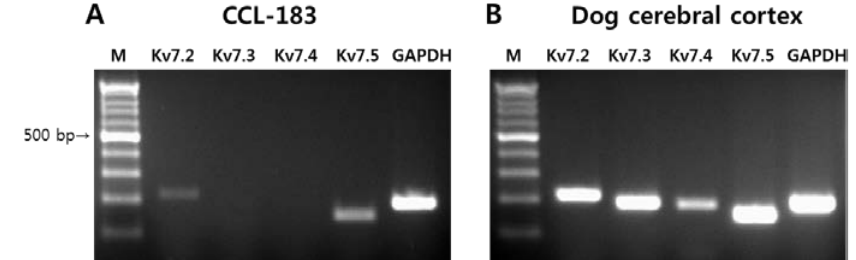
Figure 1. RT-PCR analysis of the KCNQ gene family. PCR products using cDNA from the CCL-183 cell line ( A ) and dog cerebral cortex ( B ) were electrophoresed on a 2% agarose gel. M, DNA ladder.